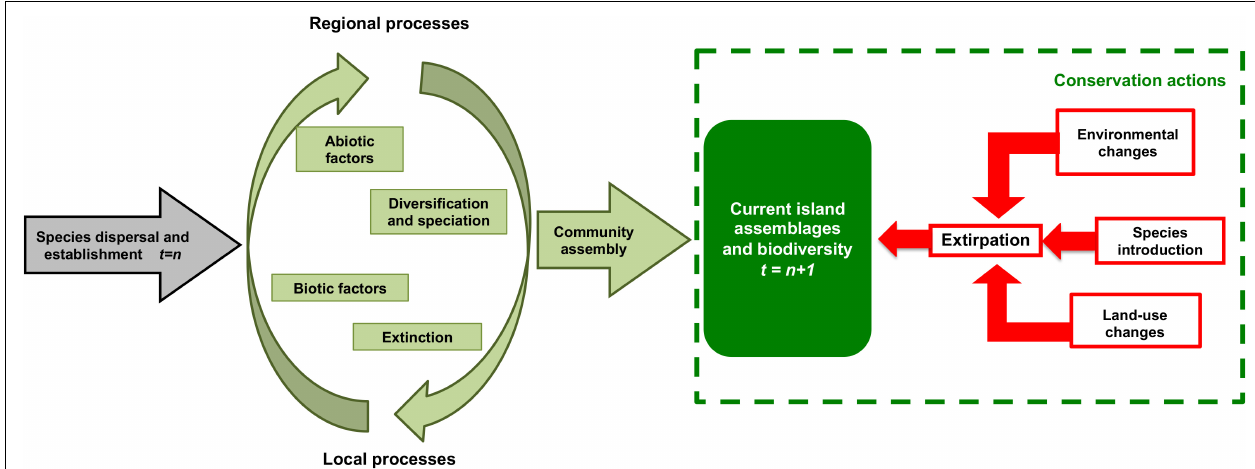
FIGURE 3 | Processes leading to community assembly in island biotas. The grey arrow represents dispersal from the species pool since historical times ( t = n ). Species able to colonise an island are subject to several processes and factors acting at the regional and local scales (some examples of these are indicated inside the two green arrows conforming a circle), which can lead to community assembly (large green arrow) and to the current biodiversity on islands (green box; t = n + 1 ). The extant island biodiversity is a result of speciation and diversification under regional and local abiotic constraints and biotic interactions. Current island assemblages and biodiversity are affected by anthropogenic disturbances such as environmental changes, species introductions and land-use changes (red arrows) that can lead to extirpation of species (red box), and are thus often targeted by conservation actions (green dashed